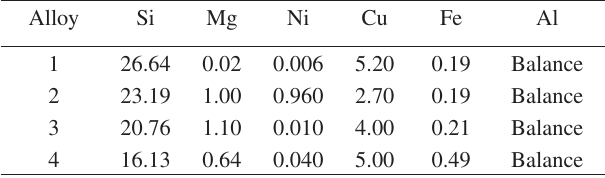
Table 1. Chemical composition (weight %) of hypereutectic Al-Si alloys obtained by atomic absorption spectroscopy and gravimetry (Si).